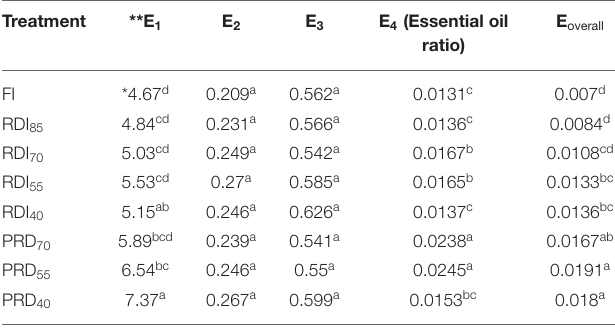
* For a given variable in each column, mean values not sharing common letters are significantly different (P ≤ 0.05), Duncan test. ** Efficiency parameters from Equations (6, 7).